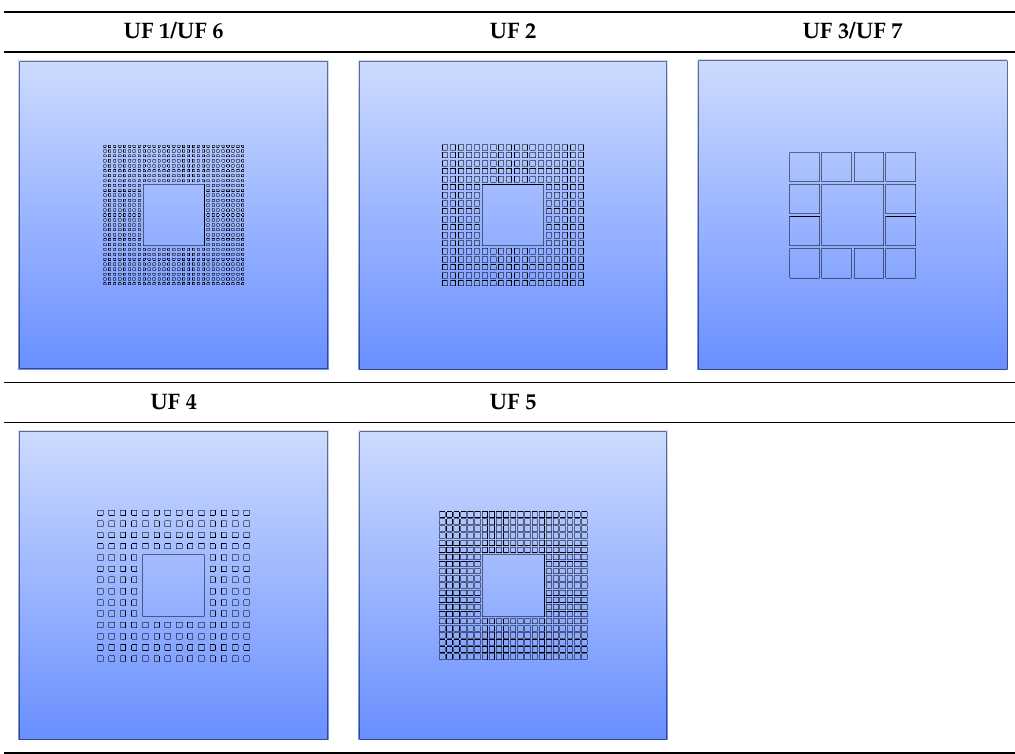
Table 2. Geometry of each urban form